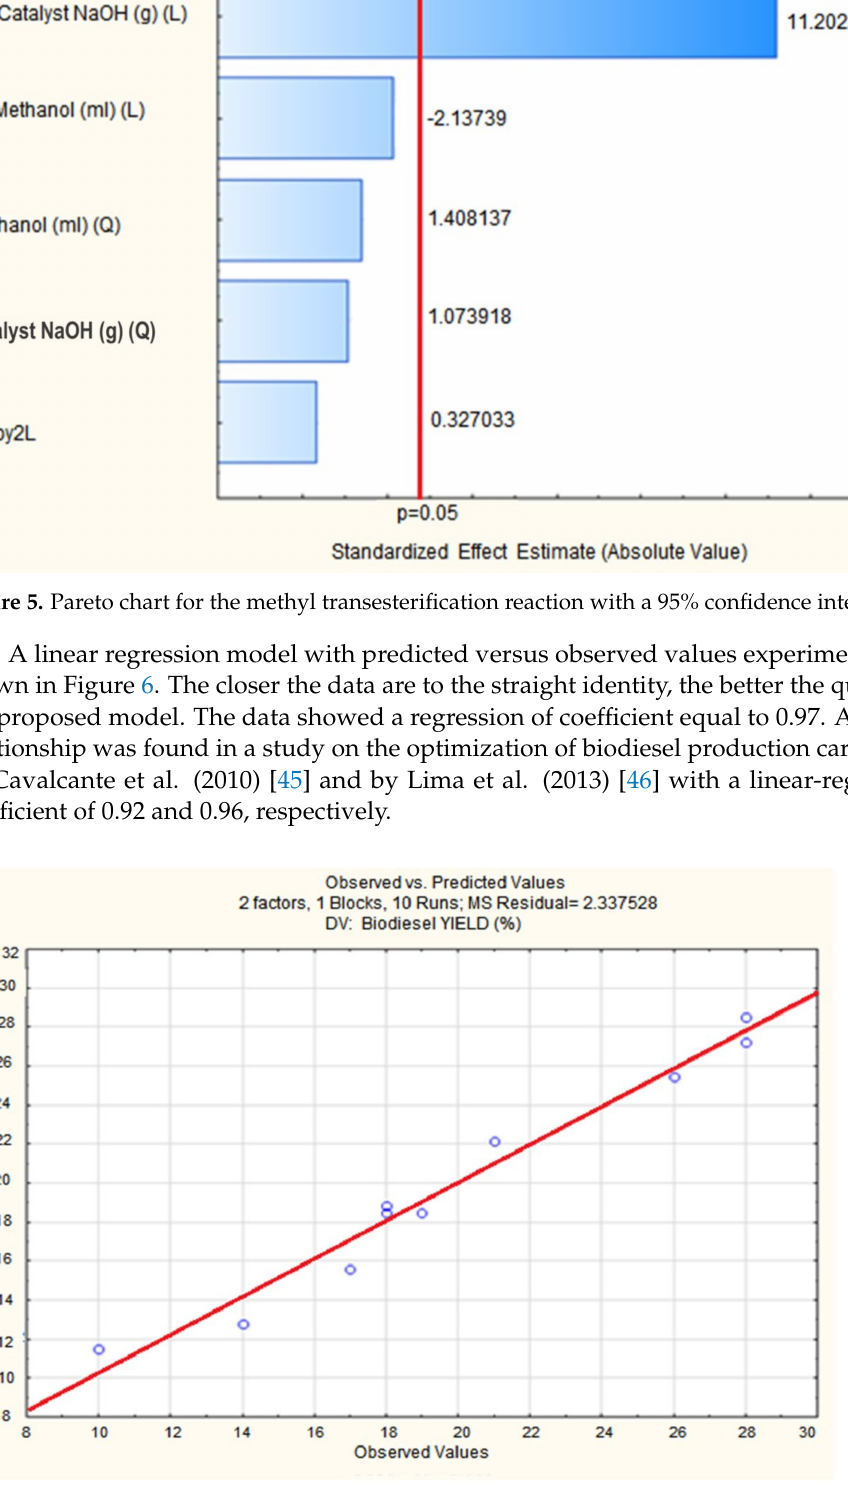
Figure 6. Predicted values vs. observed